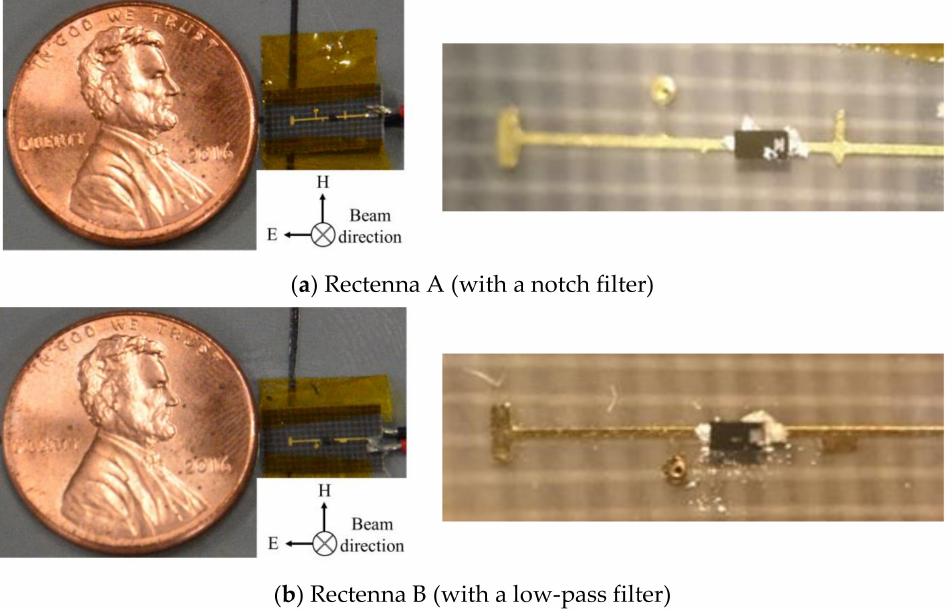
Figure 20. 303 GHz MSL rectenna: ( a ) rectenna A (with notch filter) and ( b ) rectenna B (with low-pass filter).